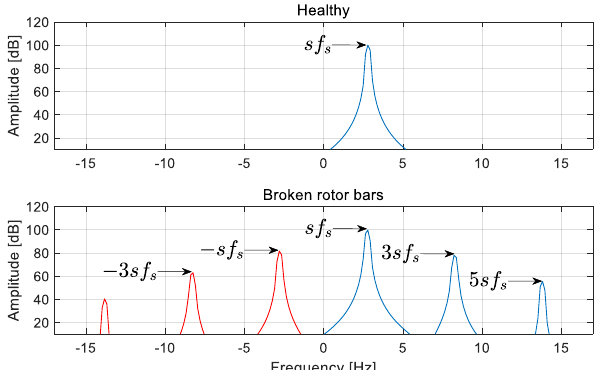
Figure 7. Example spectrum of the p -th (blue color) and (N-p) -th (red color) symmetrical component of rotor currents for healthy machines and machines with a broken rotor cage bar.